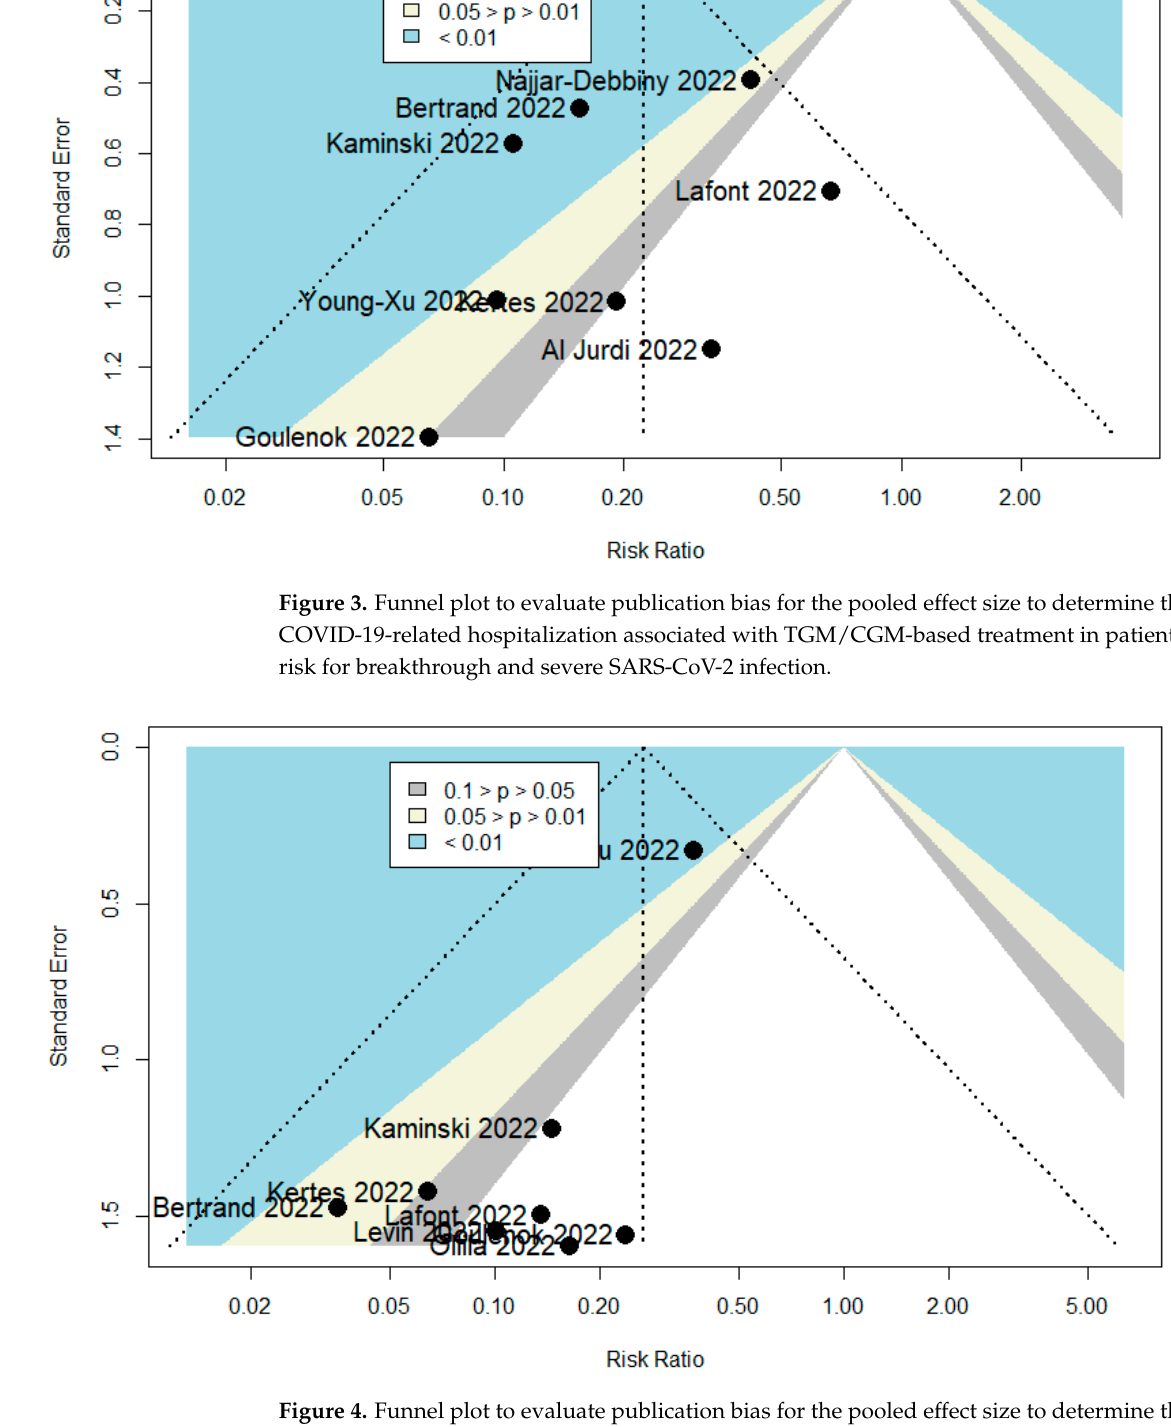
Figure 4. Funnel plot to evaluate publication bias for the pooled effect size to determine the rate of mortality associated with TGM/CGM-based treatment in patients at high risk for breakthrough and severe SARS-CoV-2 infection.